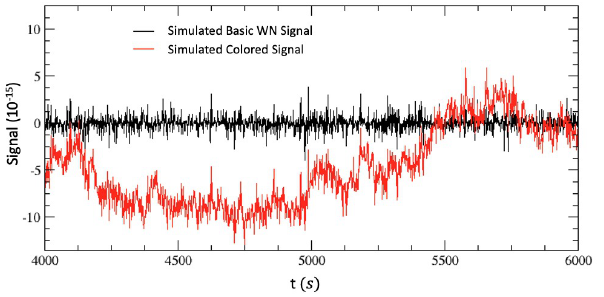
Figure 12. We report two typical sets of 2000 s for our basic white-noise (WN) signal and its colored version, which was obtained with a Fourier transform of the spectral amplitude from [25].